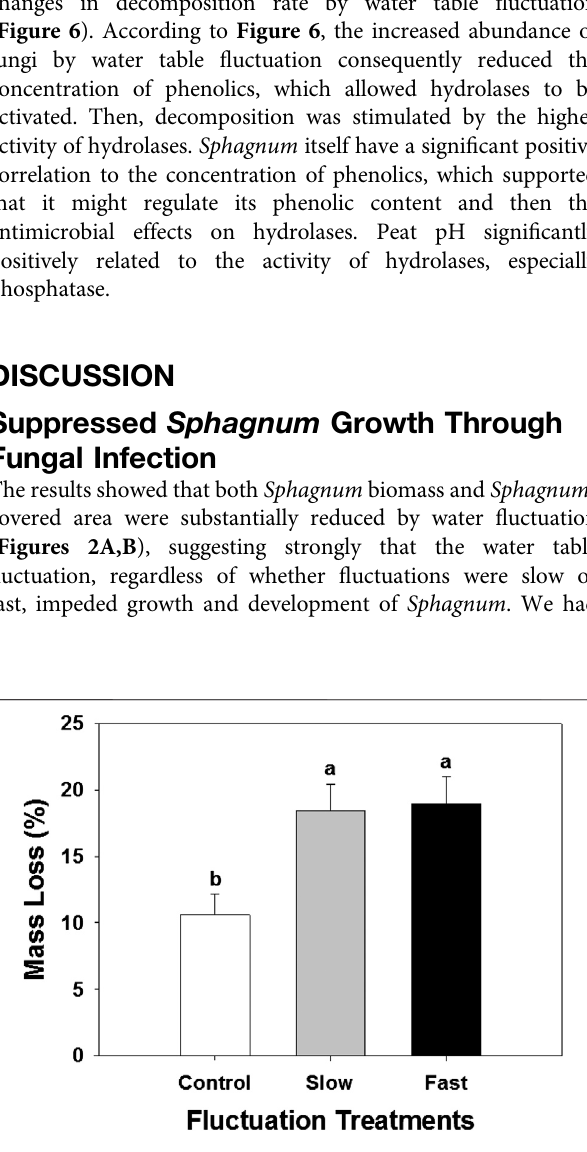
FIGURE 4 | Mass loss determined by decomposition litter bag experiment. Letter denotes statistically signi fi cant differences between treatments (n (cid:2) 60, p <